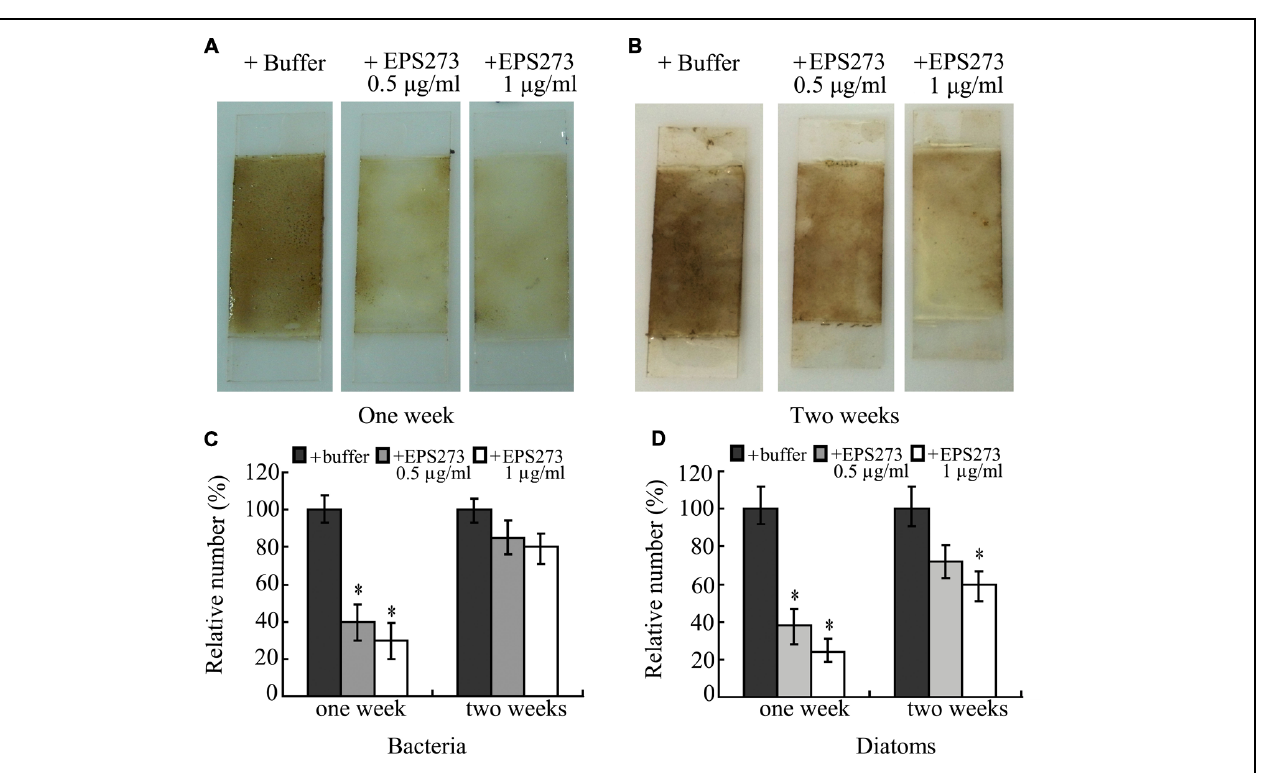
FIGURE 8 | Antibiofouling activity of EPS273 in marine environment. (A) and (B) are images of biofouling formation on glass slides precoated by paints with or without EPS273 after 1 or 2 weeks in the ocean environment, respectively. (C) and (D) are the relative amounts of bacteria and diatoms from corresponding glass slides, respectively. The amount of bacteria or diatoms from glass slides without EPS273 was set at 100%. Error bars indicate the standard deviations of three measurements. ∗ P < 0.05 versus the